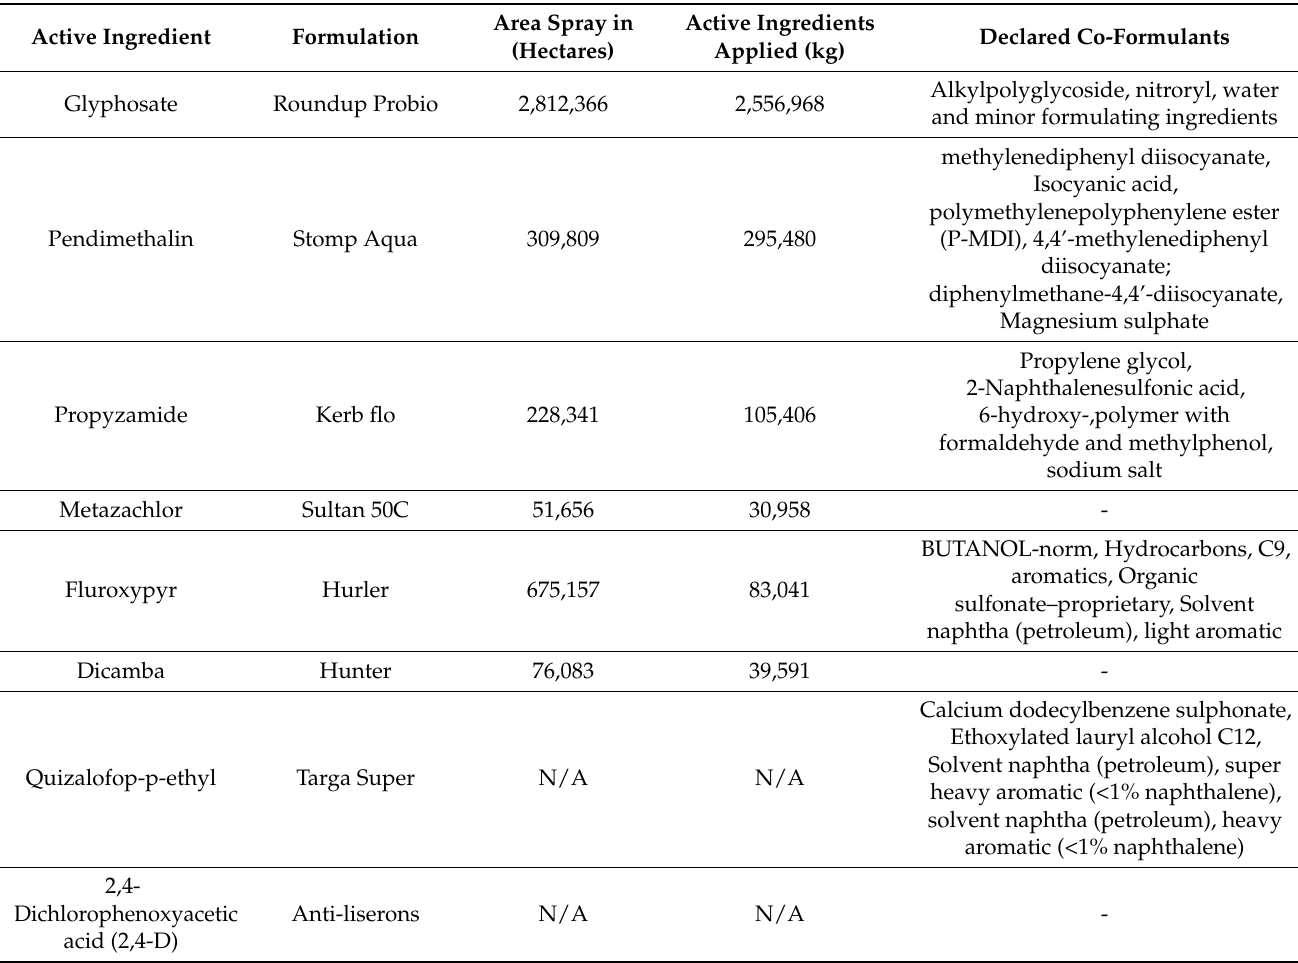
Table 1. Herbicide active ingredients and representative commercial formulations used in this